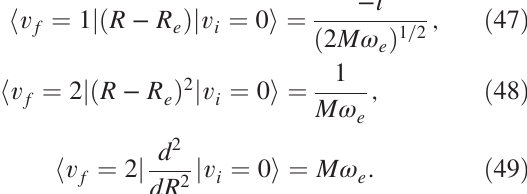
, e are e (for ground b